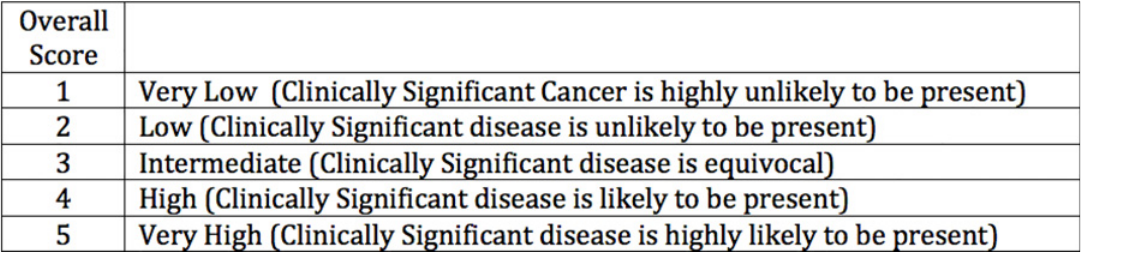
Fig 5. 5-point scale: Overall SQS Score and PI-RADS use the same terminology for